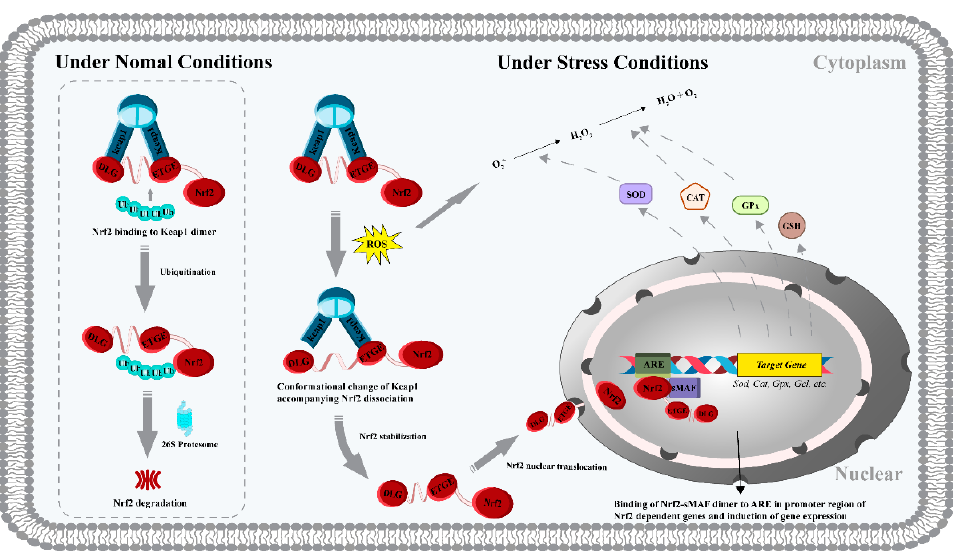
Figure 2. Schematic showing the regulatory mechanism of the Keap1-Nrf2-ARE pathway. Under normal physiological conditions, the Keap1 dimer binds to two binding motifs, called DLG and ETGE, in a specific domain of Nrf2, allowing Nrf2 to be sequestered in the cell membrane and maintained at low levels by Keap1-dependent ubiquitination and proteasomal degradation. Under oxidative stress, such as the presence of reactive oxygen species (ROS), the conformation of Keap1 changes, resulting in the release of Nrf2 from Keap1-directed degradation, which translocates in the nucleus and forms a dimer in sMAF. The polymer formed leads to the induction of ARE-dependent genes such as Sod, Cat, Gpx, and Gcl. These gene products subsequently exert cytoprotection against ROS. Ub, ubiquitin.